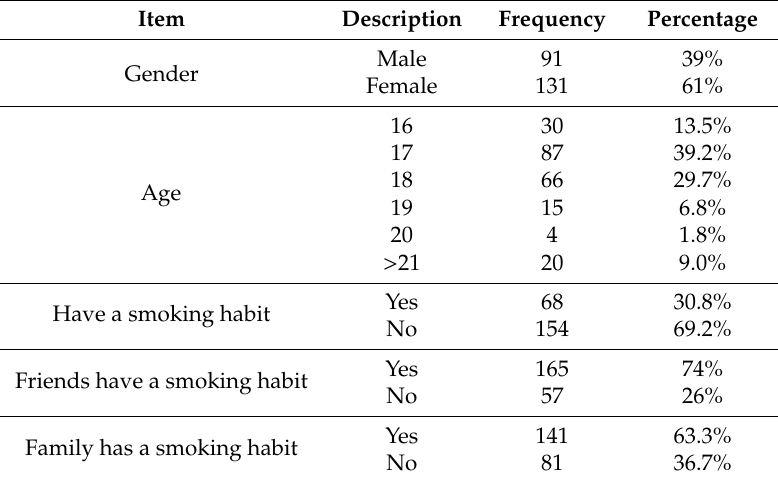
Table 4. Description of respondents in Study